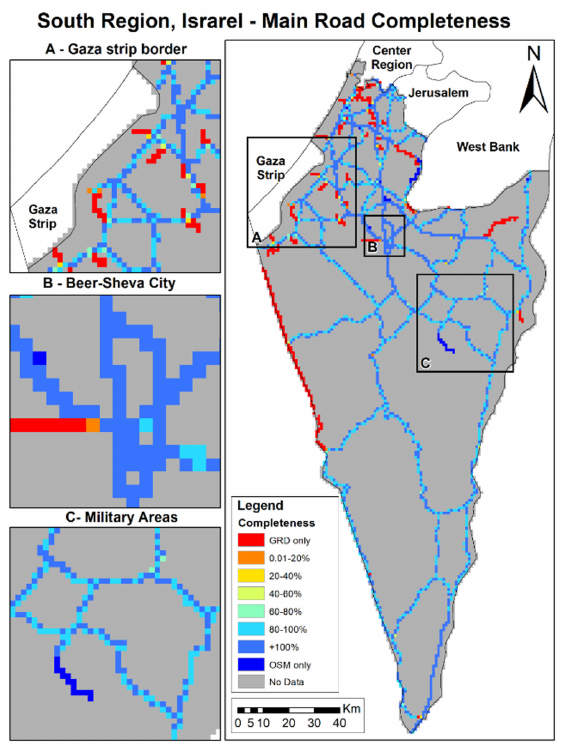
Figure 4. Israel’s south region’s completeness